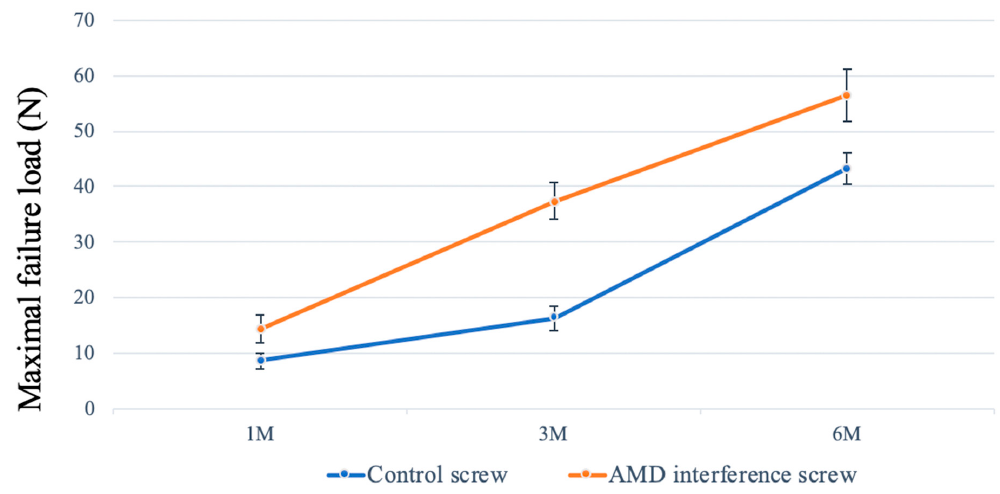
Figure 3. Biomechanical assessment. The mean maximal failure load in the AMD screw group was significantly higher than that in the control group at 1, 3, and 6 months ( p < 0.05). The error bar denotes the standard deviation.